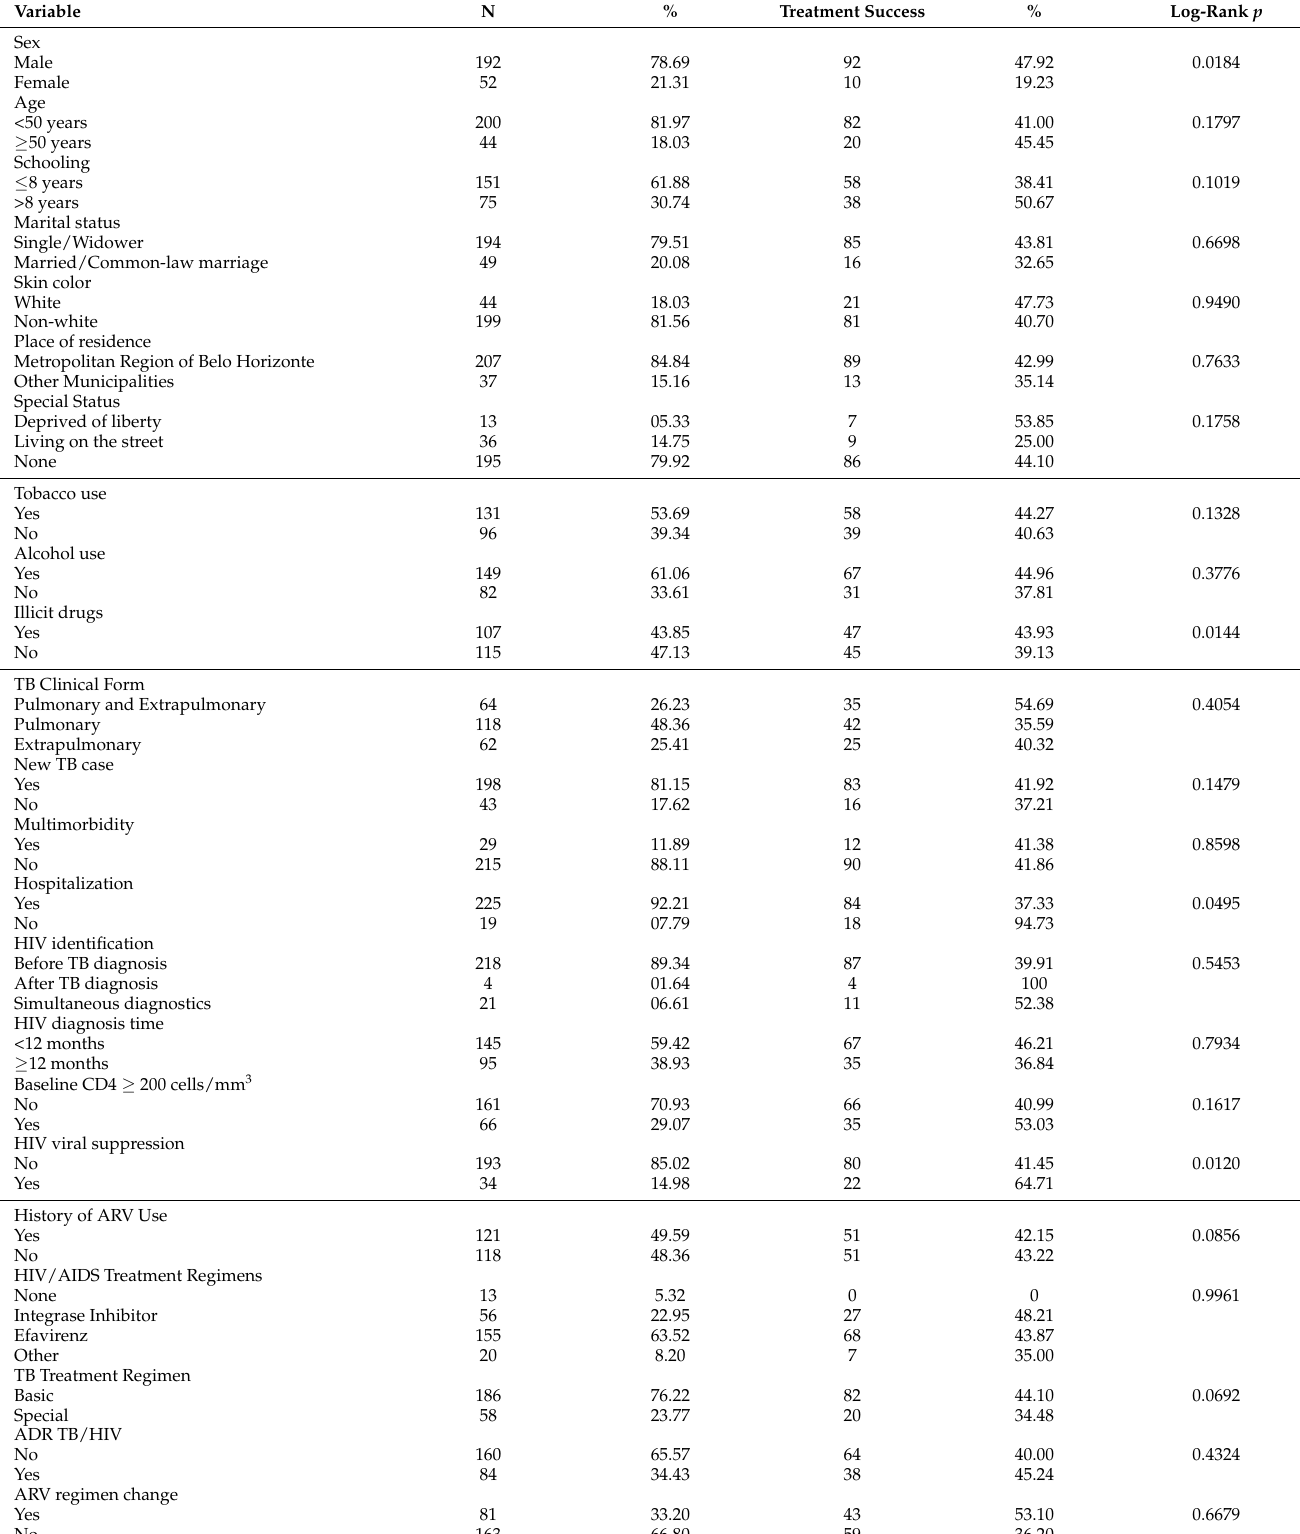
Table 1. Sociodemographic, behavioral, clinical, and drug treatment characteristics ( n =